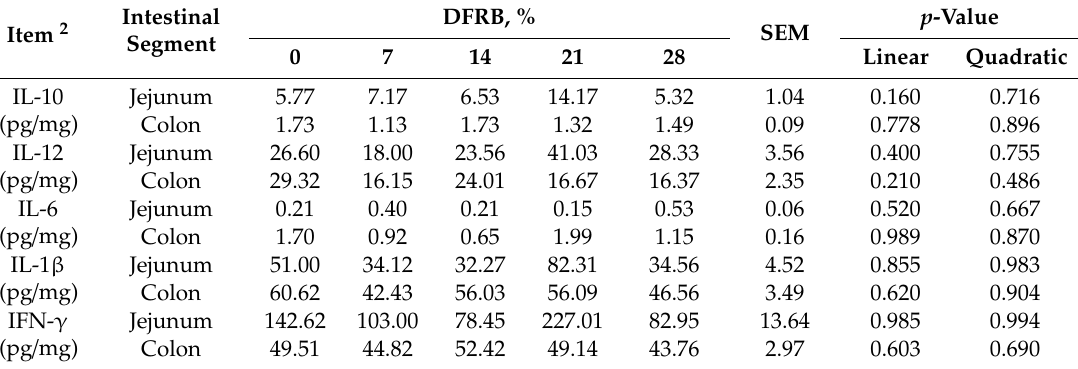
Table 7. E ff ects of increasing DFRB supplementation on cytokines in jejunum and colon of finishing pigs 1 .